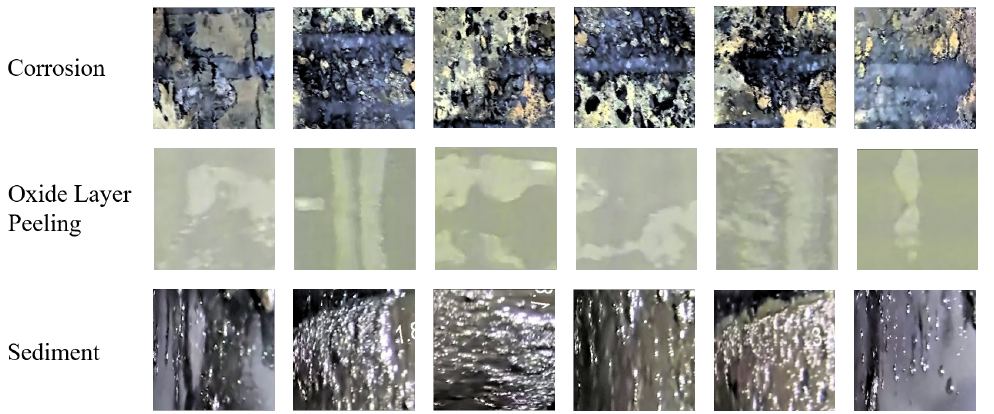
Figure 10. Local images of corrosion, oxide layer peeling, and sediment.